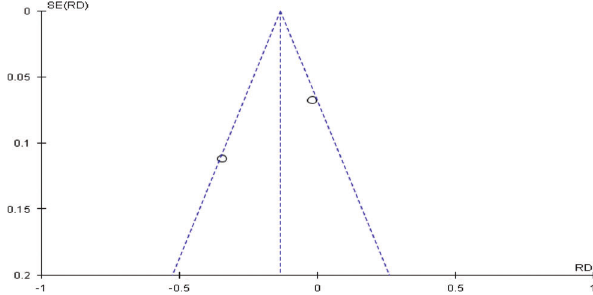
Figure 10 - Funnel plot of minor complications in randomized studies. The heterogeneity between studies was high (Figure 11, Chi 2 =6.31, DF=1 ( p =0.01), I 2 =84%), which may have been due to the varying characteristics of the studies, times of publication and distributions of the populations as well as other population differences. However, two studies were found to lie inside the funnel plot, demonstrating true heterogeneity.